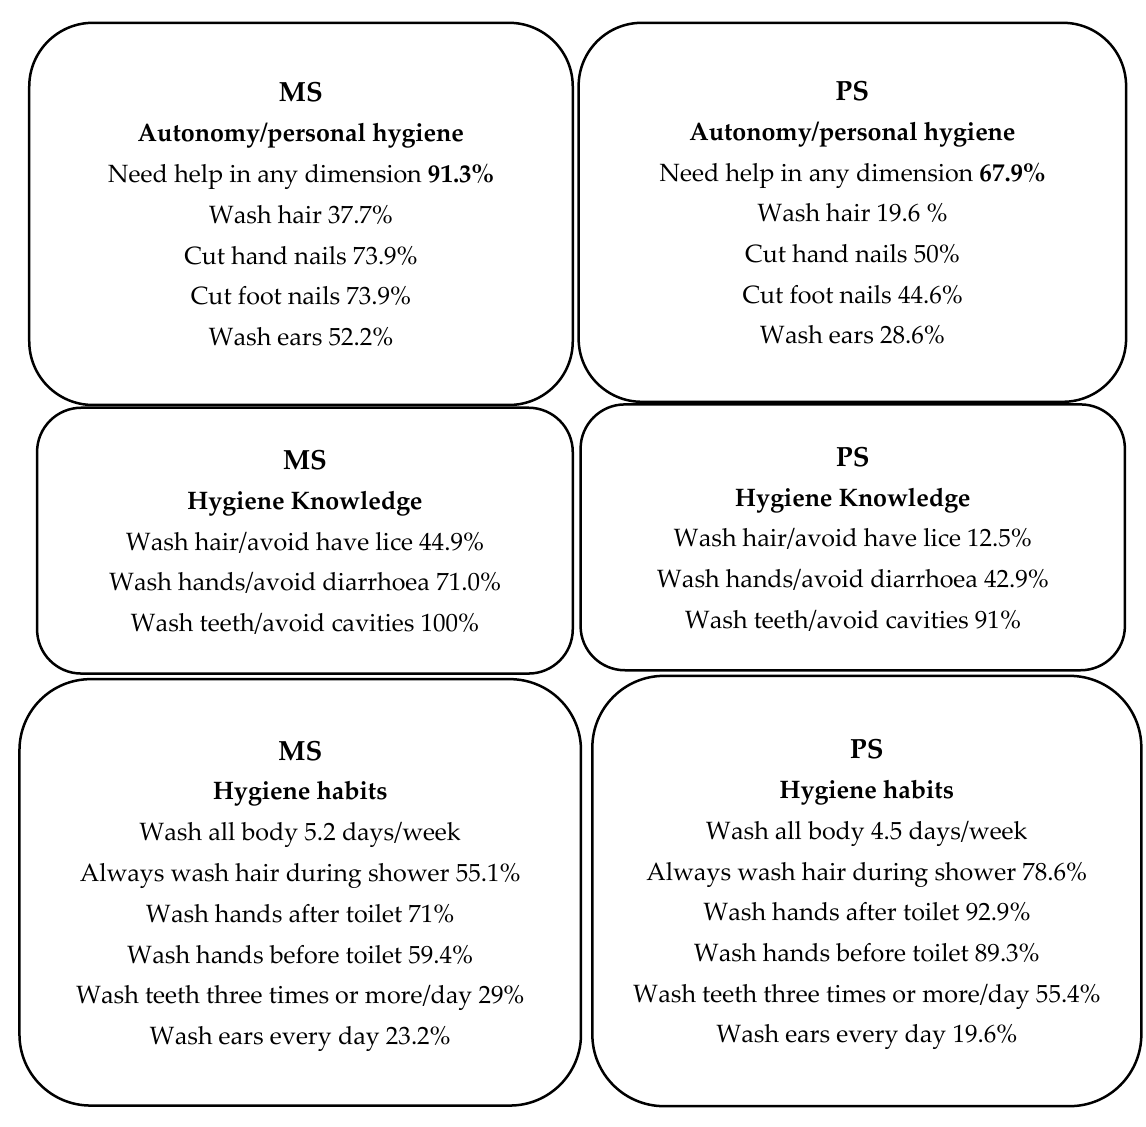
Figure 2. Graphical illustration of the results in the differences in the three dimensions analysed (personal autonomy, habits, and knowledge hygiene) related to the kind of schooling. MS: Mainstream Schooling; PS: Preferential Schooling; %: percentage.